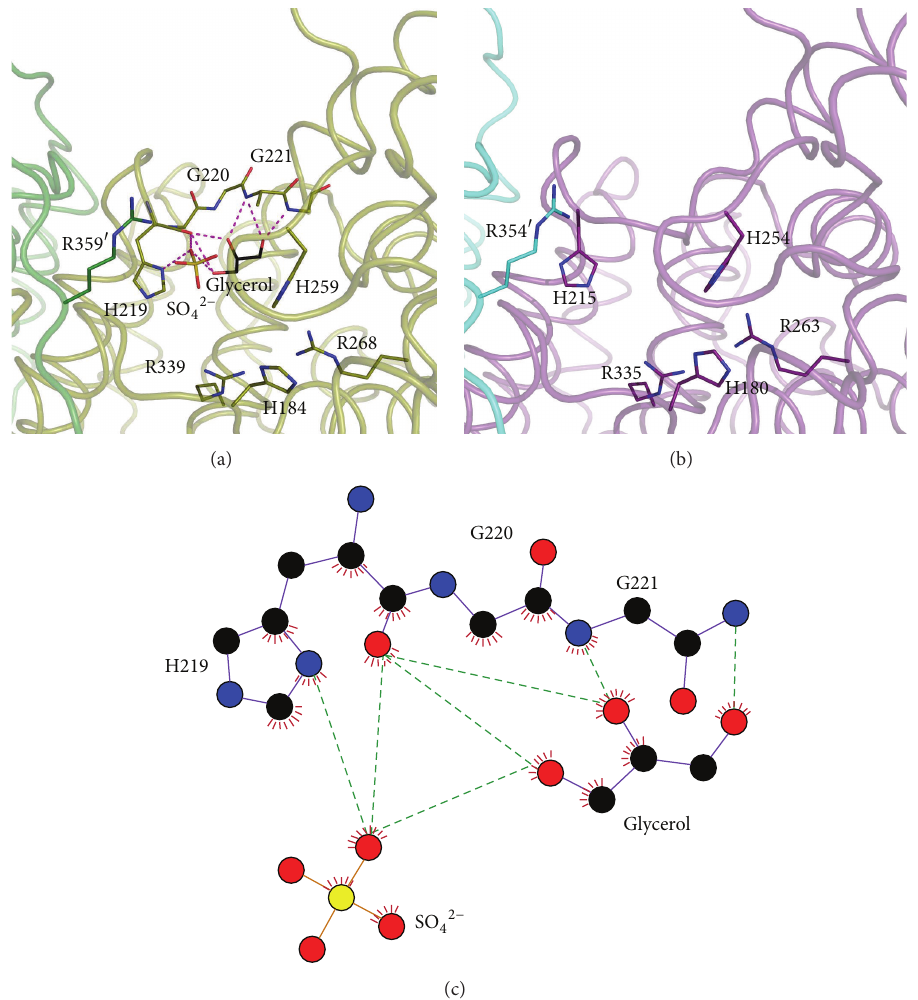
Figure 5: View in the active site of ST1805-CS (a) and ST0587-CS (b), respectively. Polypeptide chains are drawn in a ribbon model. (c) Schematic diagram of ligand binding mode in the active site of ST1805-CS. Oxygen, nitrogen, and sulfur atoms are shown in red, blue, and orange, respectively. Dotted lines indicate hydrogen bonds.